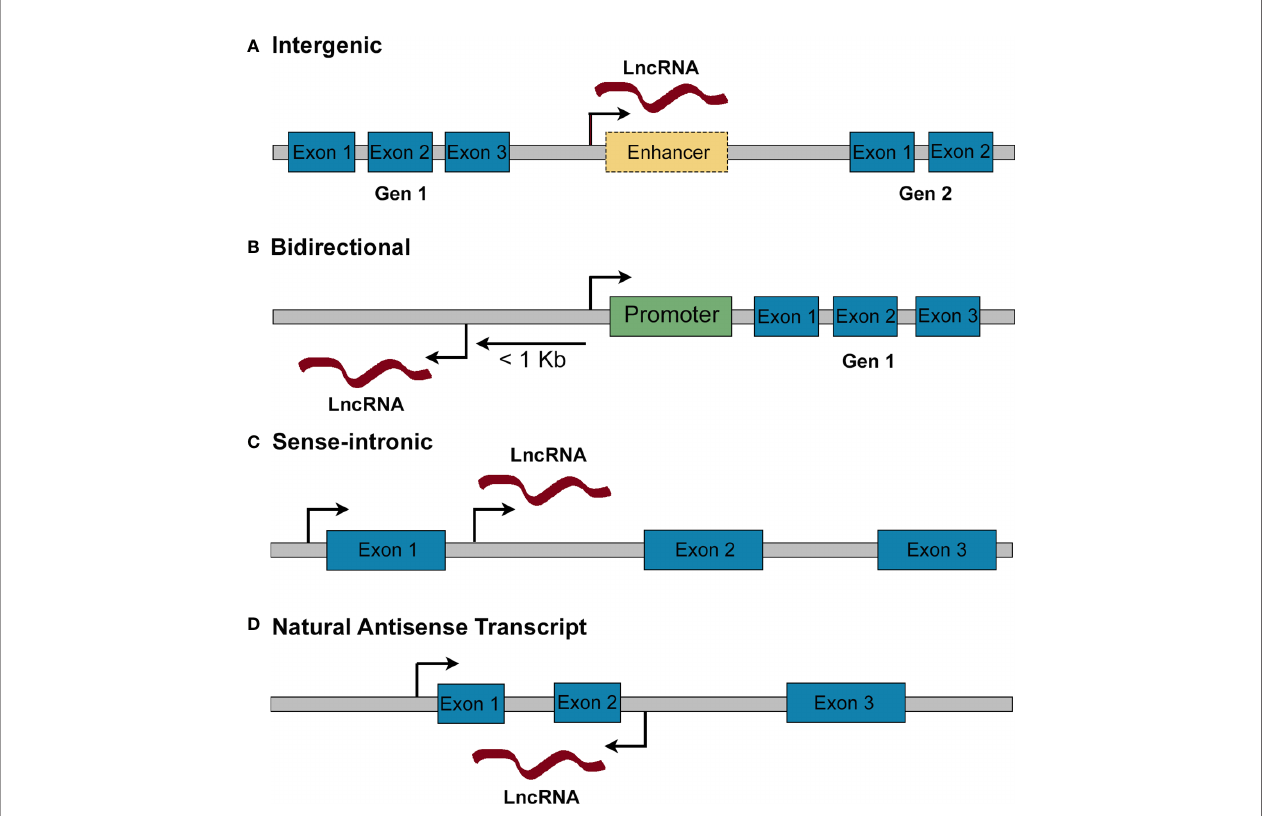
FIGURE 1 | Classi fi cation of lncRNAs according to their genomic position. (A) Intergenic lncRNAs are found in gene deserts between two protein coding genes. They may be subclassi fi ed into long intergenic RNAs and enhancer RNAs (when they are transcribed from an enhancer). (B) Bidirectional lncRNAs are mapped within 1 kb from the promoter of a protein coding gene and are transcribed in the opposite direction. (C) Sense-intronic lncRNAs are transcribed from an intron of a protein coding gene in the same direction. (D) Natural antisense transcripts are transcribed from the opposite strand of a protein coding gene, overlapping partially or totally with its